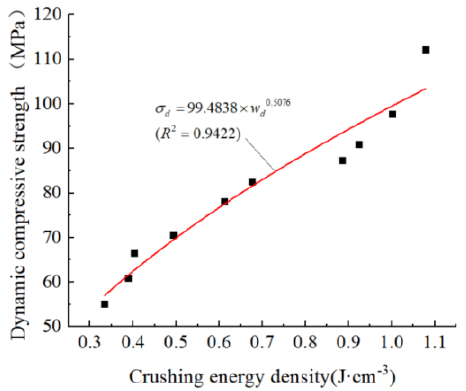
Figure 13. Relationship between dynamic compressive strength and crushing energy dissipation density of phyllite samples.